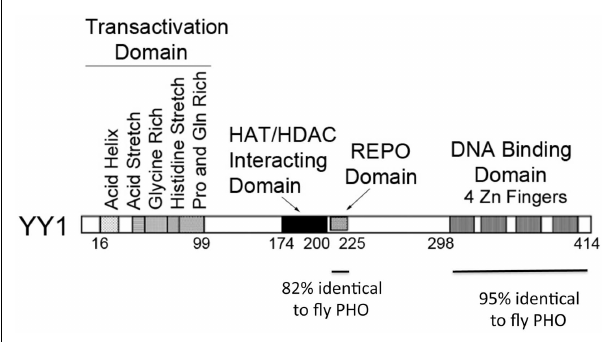
FIGURE 1 | Diagram of YY1 domains and functions . Domains of YY1 are indicated with specific functions listed.The regions of similarity to Drosophila Plieohomeotic are indicated below the